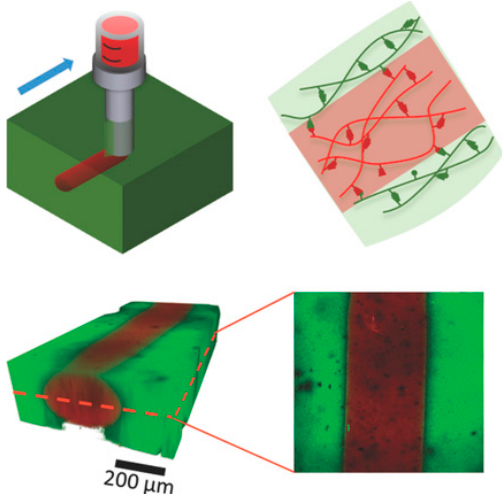
Figure 15. ( Above ): Schematic illustration of 3D printing of a supramolecular gel based on adamantane (Ad, guest) and β -cyclodextrin ( β -CD, host) conjugated to hyaluronic acid (HA). Green represents a supramolecular support gel and red the printed ink; ( Below ): 3D reconstruction of a confocal Z-stack of an ink filament (rhodamine-labeled, red ) printed into a support gel (fluorescein-labeled, green ). Scalebar: 200 μ m. Reprinted from with permission [170]. Copyright 2016 John Wiley and Sons.